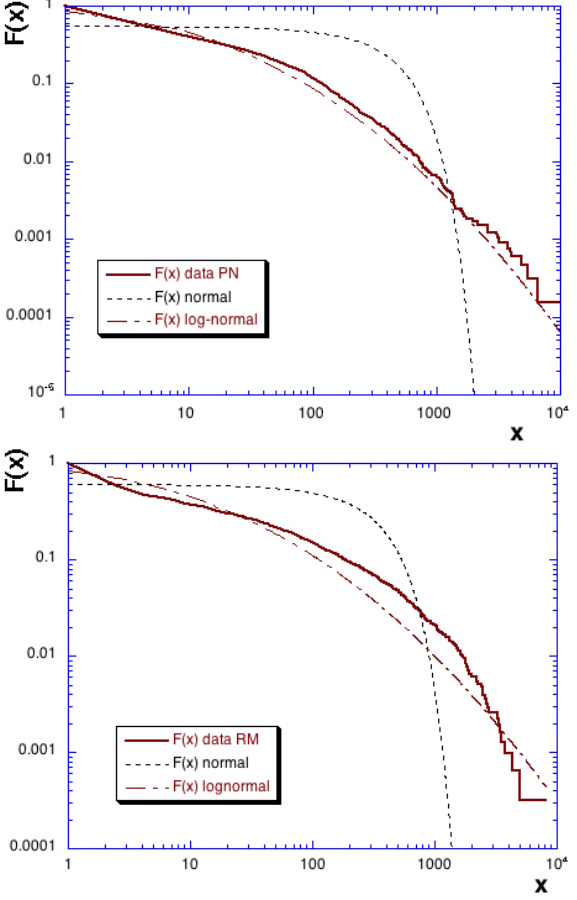
Fig. 3. The complementary cumulative distribution function (log- log plot) of polychaete abundance: (a) in Pierre Noire site (above) and (b) in Riviere de Morlaix site (below). The continuous lines correspond to the data, dotted lines to normal distributions obtained from the same mean and variance as experimental data, and dash- dotted lines to a lognormal distribution with the same mean and variance as the logarithm of experimental data.